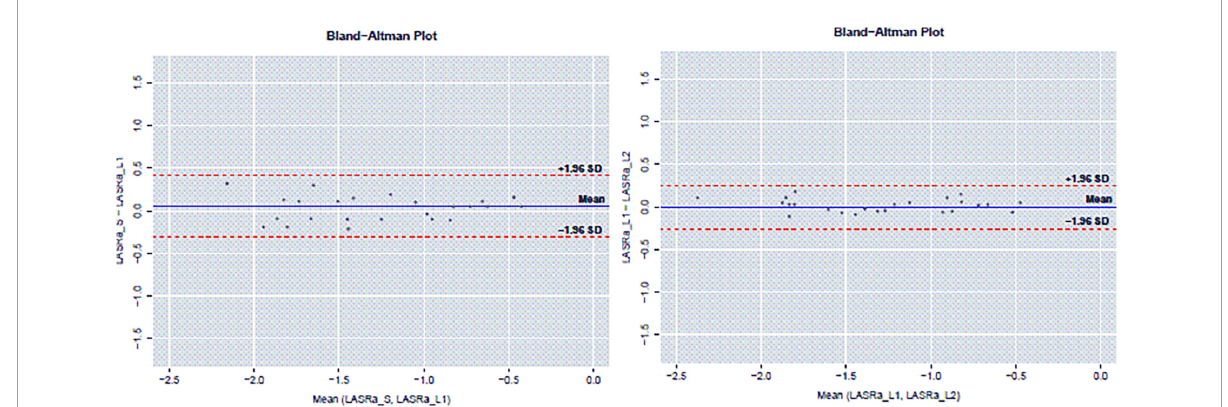
FIGURE5 Reproducibility of LASRa l measurements: inter-observer Lin concordance and intra-observer